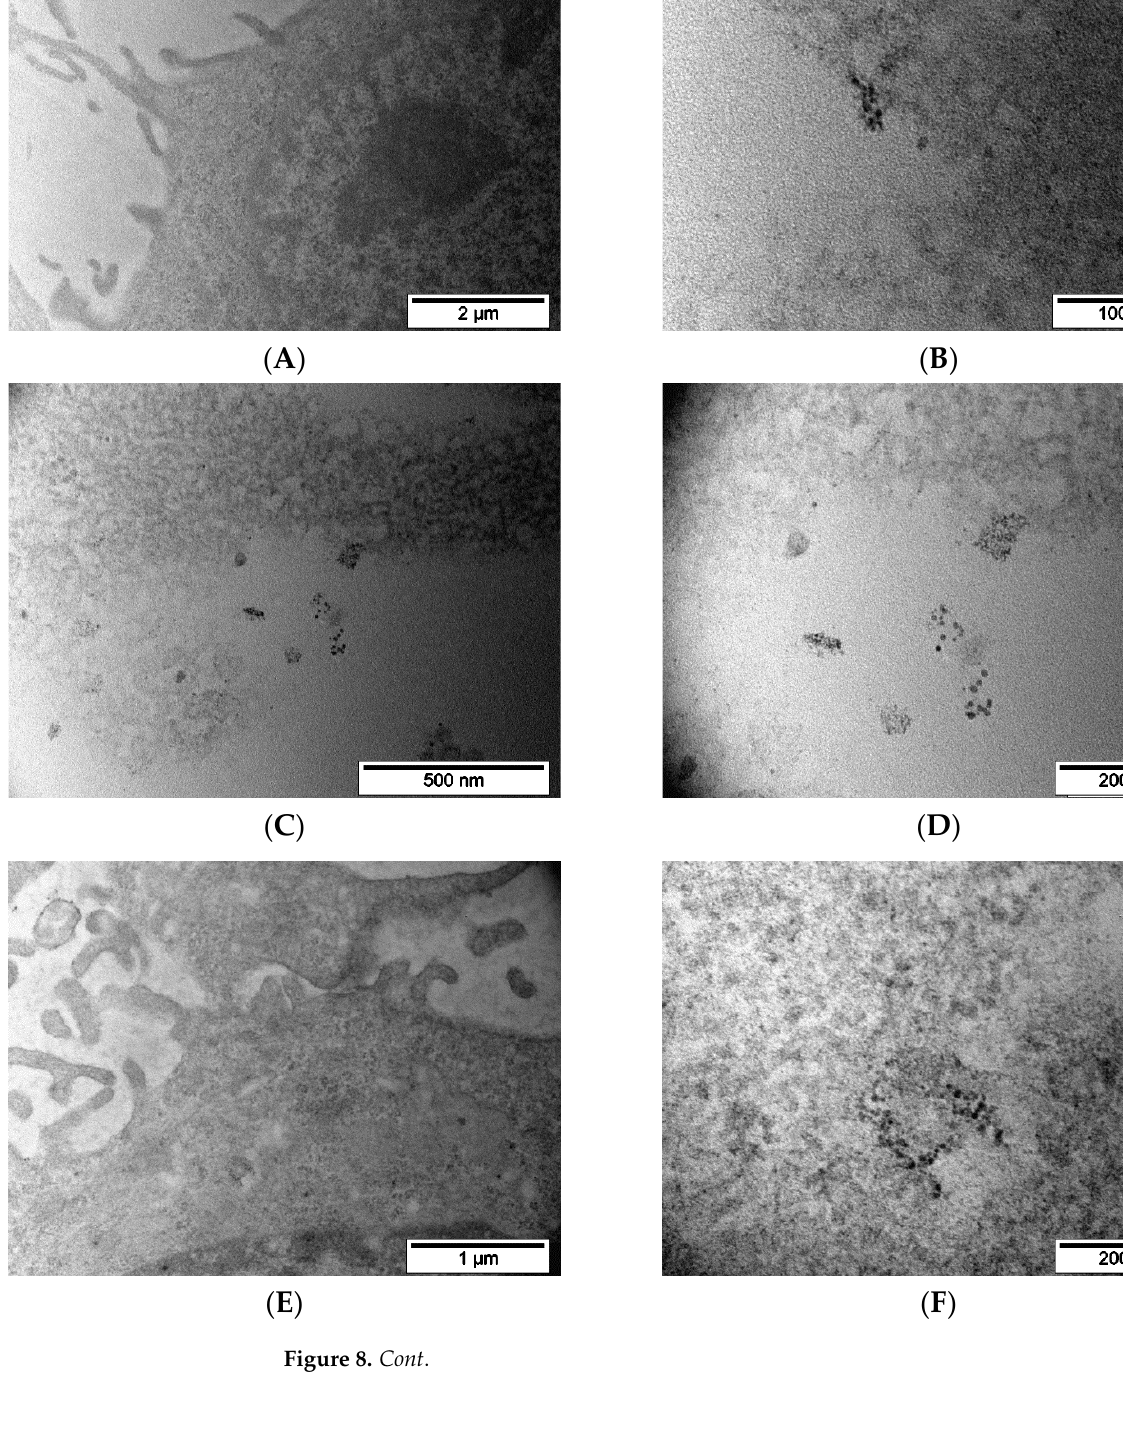
Figure 8. TEM images of the 4T1 cells after 2 h incubation with MNP-SS ( A – D ) and MNP-PEG ( E – H ): ( A )—cytoplasm of 4T1 cell with a vesicle filled with MNP-SS nanoparticles; the vesicle is enlarged in ( B , C )—outer membrane and cytoplasm of the 4T1 cell with attached clumps of MNP-SS nanoparticles and just formed vesicles; the vesicle is enlarged in ( D )—filled with nanoparticles; ( E )—4T1 cell plasmalemma with attached MNP-PEG nanoparticles, enlarged in ( F – H )—MNP-PEG nanoparticles in the vicinity of the 4T1 cell plasmalemma. MNP-SS and MNP-PEG after 24 h incubation with PC-3 cells were gathered in nu- merous vesicles distributed all around the cytoplasm (Figure 9). The average amount of uptaken nanoparticles visually increased many times compared to the 2 h incubation time. No clear differences were noted in the accumulation patterns between nanoparti- cles. In both cases the vesicles were filled with nanoparticles, while no nanoparticles were observed on the plasmalemma. The observed vesicles with the nanoparticles after 24 h of incubation might be lysosomes. In contrast with the previous incubation time, the MNP-SS nanoparticles had no shaded shell after 24 h of incubation. This could be due to etching on the magnetic core surface and the subsequent desorption of the disul- fide-containing shell. The acidic environment near pH ~4.7 and high reducing activity of GSH have led to the intensive dissolution of the iron oxide core and the reduction of di- sulfide bonds.